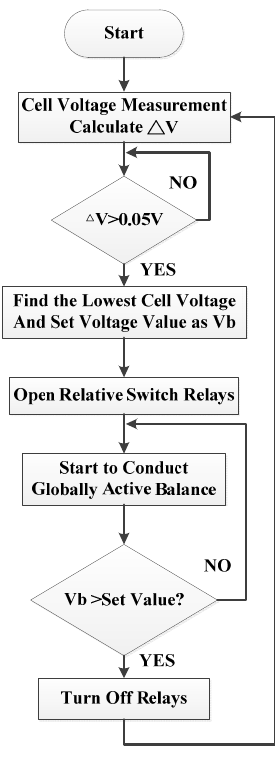
Figure 6. Two-staged charging flowchart.